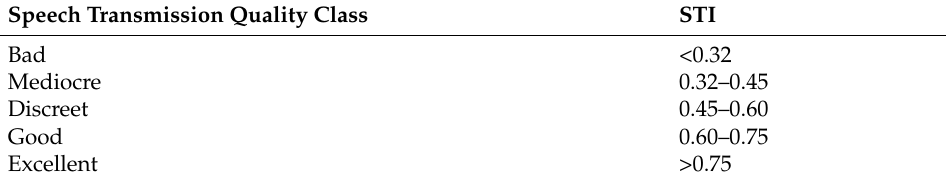
Table 5. Quality class of STI